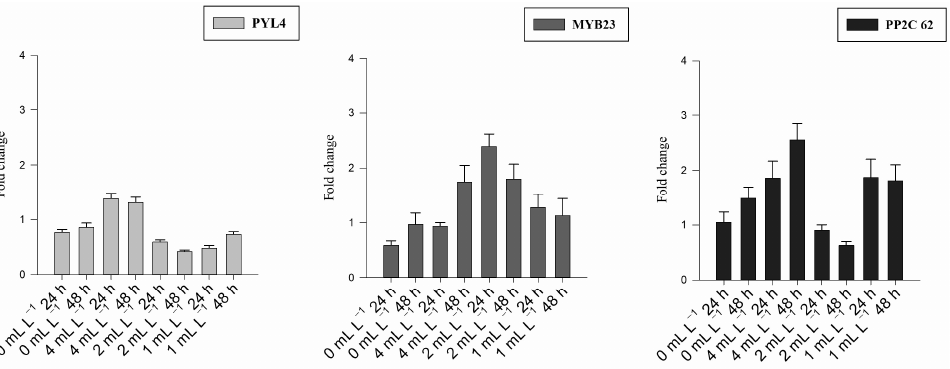
Figure 3. Fold change for the gene expression analysis of the ABA-related genes 24 and 48 h after treatment for all the BSE concentrations (0 mL L −1 : untreated; 4 mL L −1 ; 2 mL L −1 ; 1 mL L −1 ). Each bar-plot shows the mean of eight replicates with the standard error of the mean.